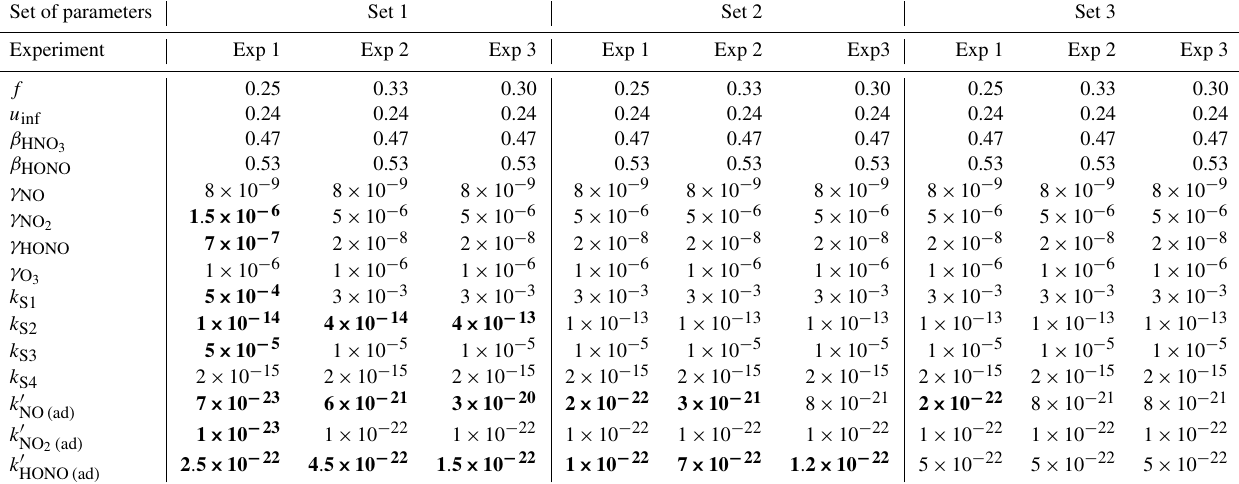
Table 5. Parameter values for each type of simulation and each experiment. The parameters are as follows: filtration factor [–], velocity of air [ms − 1 ], NO 2 hydrolysis stoichiometric coefficients [–], uptake coefficients γ i [–], surface reactions kinetic rates k S [s − 1 ], desorption reactions kinetic rates k (cid:48) [s − 1 molec. − 1 ]. Set 1 refers to the simulations with optimized parameters, Set 2 refers to the i, (ad)